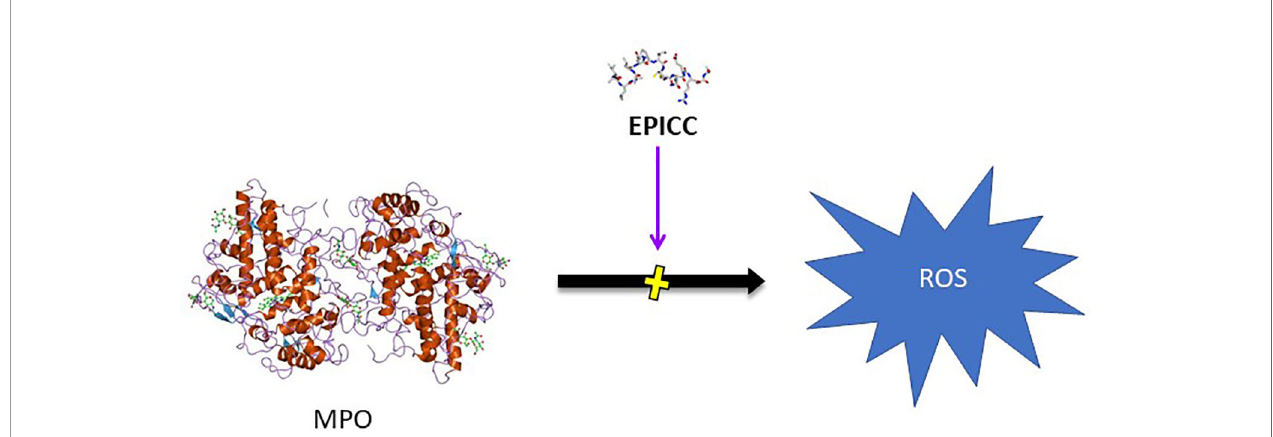
FIGURE 2 | Inhibition of MPO activity by EPICC peptides. MPO released from neutrophils generates reactive oxygen species (ROS) which results in host tissue damage in in fl ammatory disease conditions. EPICC peptides directly bind MPO and prevent the peroxidase activity of MPO through an antioxidant mechanism that is mediated by cysteine residues in the